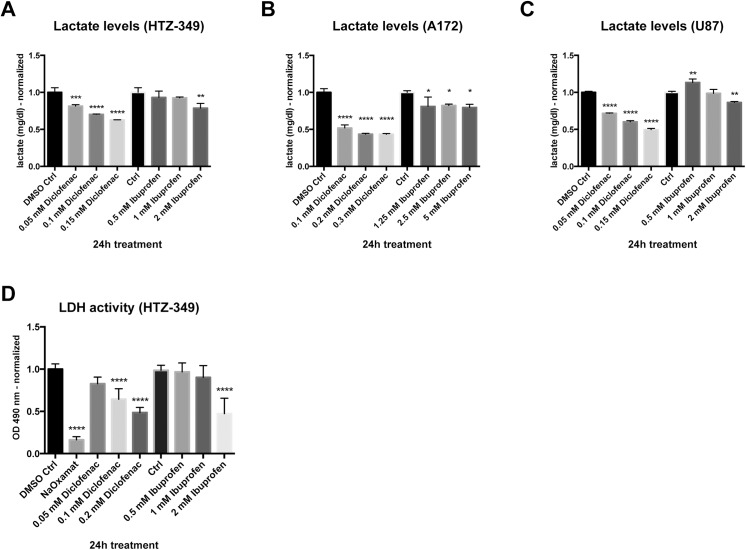
Ibuprofen and diclofenac decrease lactate levels and LDH activity.Human glioma cell lines HTZ-349, A172, and U87MG (105 cells/well) were cultured for 24 h with increasing concentrations of ibuprofen or diclofenac as indicated, then supernatants were harvested for lactate level measurement (A–C). Measurements were normalized to cell number. Diclofenac treatment resulted in a significant decrease of lactate at all concentrations and in all cell lines. In contrast, ibuprofen cause a reduction of lactate accumulation only at concentrations of 2 mM in HTZ-349 and U87MG. These observations are reflected by LDH activity measurements (D) which exhibited decreased activity with increasing concentrations of diclofenac. LDH activity reduction with ibuprofen treatment occurred only at a concentration of 2 mM. Statistics: 95% CI, * = 0.05 > p ≤ 0.01, ** = 0.01 > p ≤ 0.001, *** = 0.001 > p ≤ 0.0001, **** = p < 0.0001.